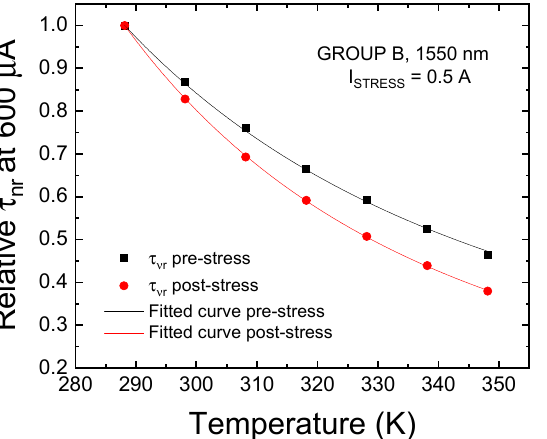
Figure 12. Relative trend of the Shockley-Read-Hall (SRH) lifetime with temperature, estimated before and after 9000 min of aging at 0.5 A for LEDs of group B.